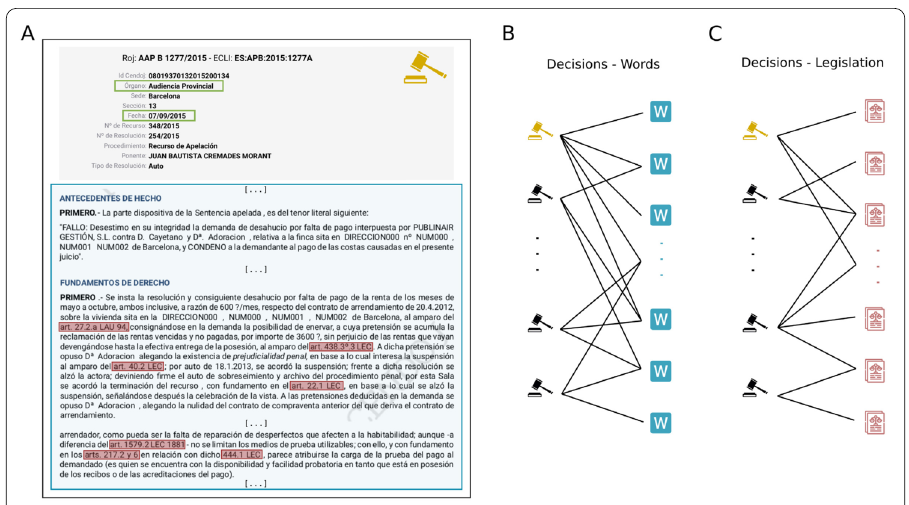
Figure 1 Representing judicial decisions as bipartite networks. ( A ) For each decision in the corpus we consider the words used (blue), the cited legislation (red), and metadata such as the date of the ruling and the court (green). We then create two bipartite networks: ( B ) A network of decisions and words; ( C ) A network of decisions and cited legislation. We select relevant words through a process of n-gram extraction and